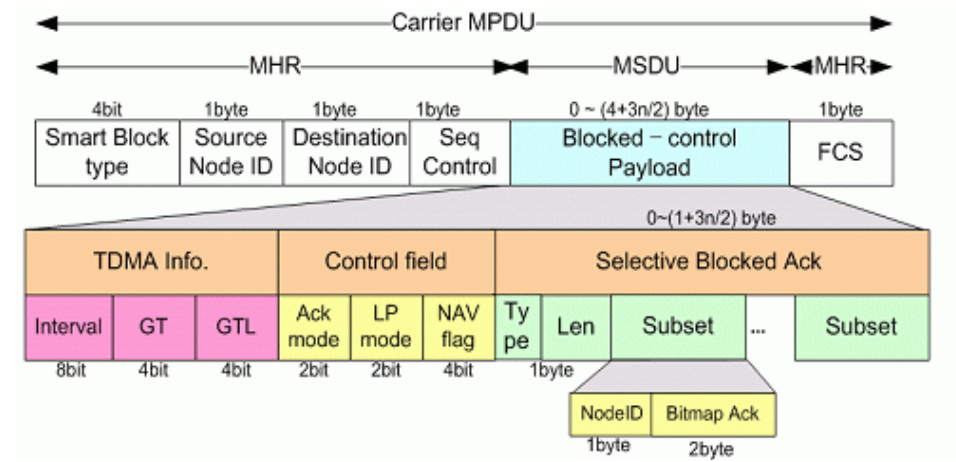
Figure 10. Beacon Frame with